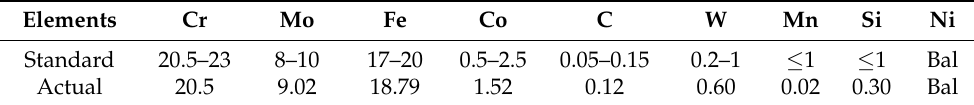
Table 1. Chemical composition of Hastelloy-X nickel base superalloy powder (wt.%).